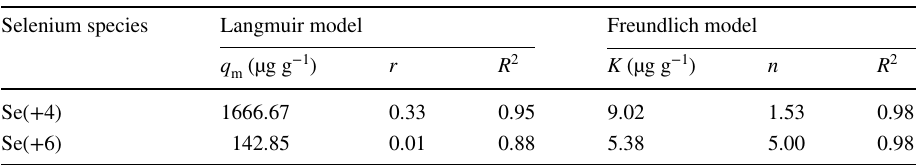
Table 1 Parameters of Langmuir and Freundlich model for selenite and selenate adsorption onto MAA